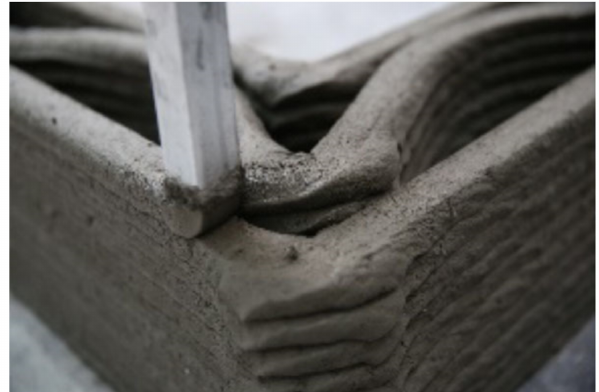
Figure 8. WinSun Wall configuration [31]. Reprinted with permission from Ref. [31]. 2017, Yingchuang Construction Technology (Shanghai) Co., Ltd.